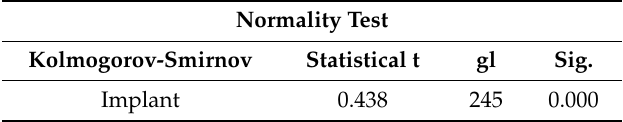
Table 3. Normality test